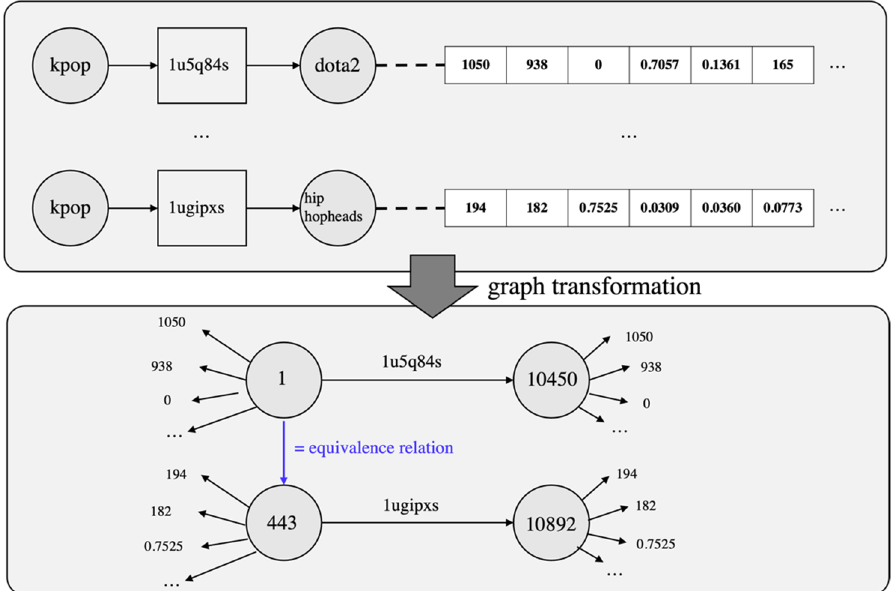
Figure 6. Graph transformation process to convert redditLinks graph to KG-like structure. Table 1. The summary of the transformed dataset from redditLinks .